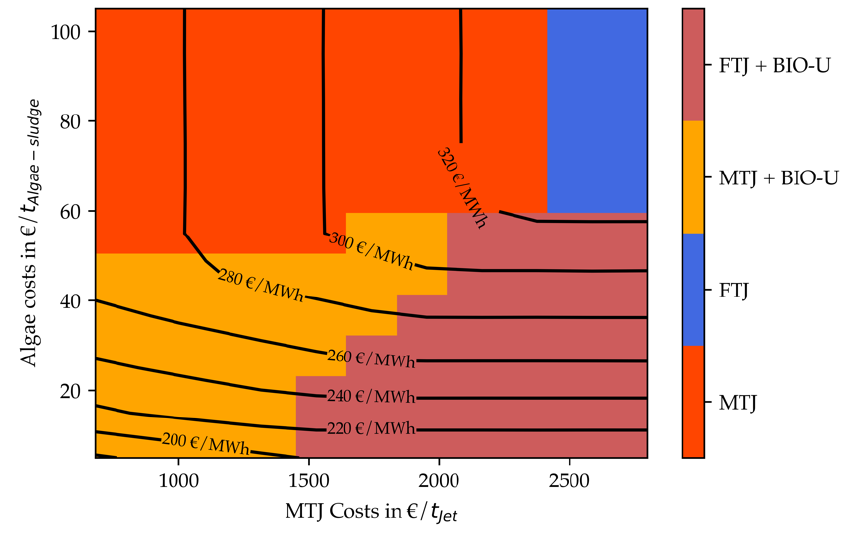
Figure 15. Net production costs (contour lines) and technology choice (heatmap) of optimized renewable refinery depending on algae costs and MTJ costs in scenario 1.